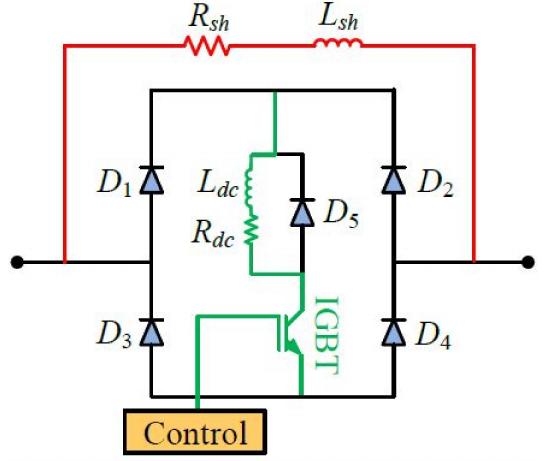
Figure 11. Control structure of BFCL in DFIG and PMSG wind turbines.